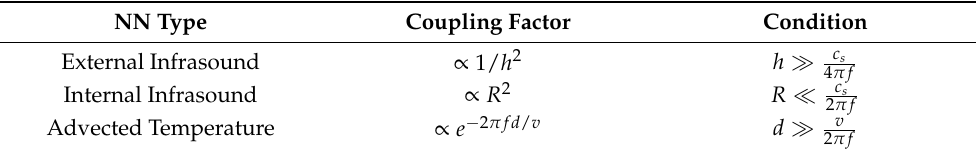
Figure 11. ANN generated by external infrasound and advected temperature fields at the Earth’s surface compared with the sensitivity of Virgo foreseen for O4 and with the ET-D sensitivity curve. The ET curve was plotted only to show that building ET on the surface would lead to the requirement of reducing ANN generated by infrasound and advected temperature fields of some orders of magnitude. The ANN produced by infrasound and advected temperature fields were calculated with the models of [35]. The curves for the NN from advected temperature fields were estimated for wind velocities of 10 m/s and 30 m/s. The necessary data to plot the NN produced by infrasound fields were taken from the 75th percentile of Figure 3 in [43]. Table 1. Comparison between the square root of the power spectral densities of the ANN generated by different mechanisms: h is the depth of the underground interferometer, R is the radius of the cavern/room, and d is the shortest distance between the test mass and the moving air